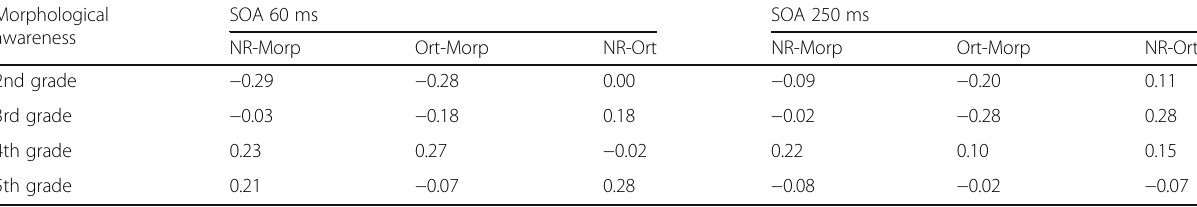
Table 2 Correlations between morphological priming scores and morphological awareness Morphological